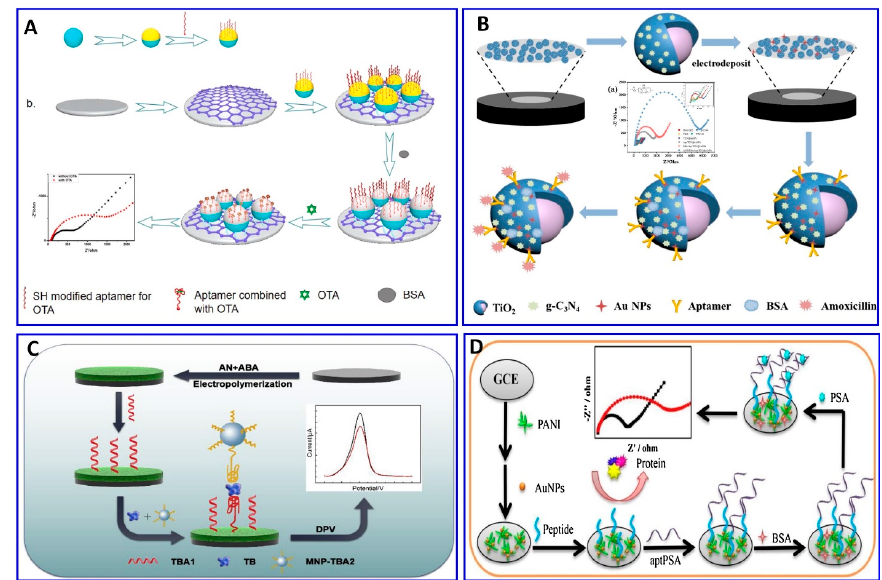
Figure 9. ( A – D ) Schematic illustrations for the fabrication of electrochemical aptasensors. ( A ) Impedimetric assay using glassy carbon electrode (GCE) immobilized with OTA aptamer, reproduced from [190]. ( B ) Impedimetric assay for amoxicillin based on the synergetic effect between the amoxicillin and its aptamer on the surface of the GCE coated with TiO 2 - g-C 3 N 4 -AuNPs, reproduced from [191]. ( C ) A sandwich-type aptasensor for thrombin assay using CSPH hydrogel-modified electrode, reproduced from [192]. ( D ) PSA assay based on polyaniline (PANI)/AuNPs as a conducting layer on GCE immobilized with a PSA aptamer, reproduced from [193].